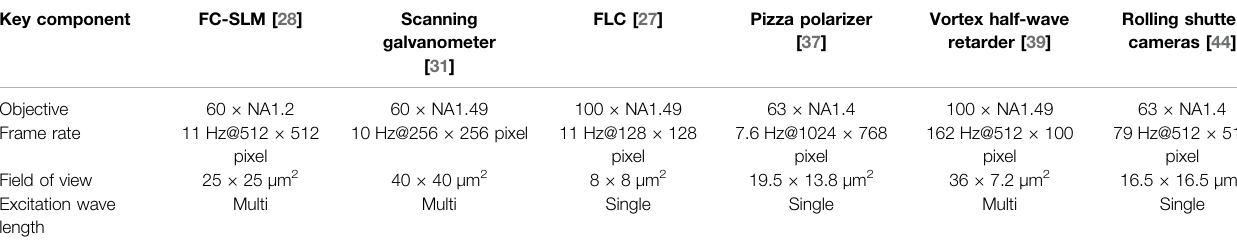
TABLE 1 | Comparison of SIM performance. Key